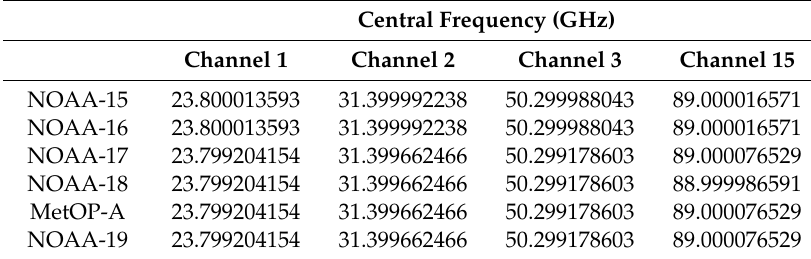
Table 2. Satellite central frequencies.